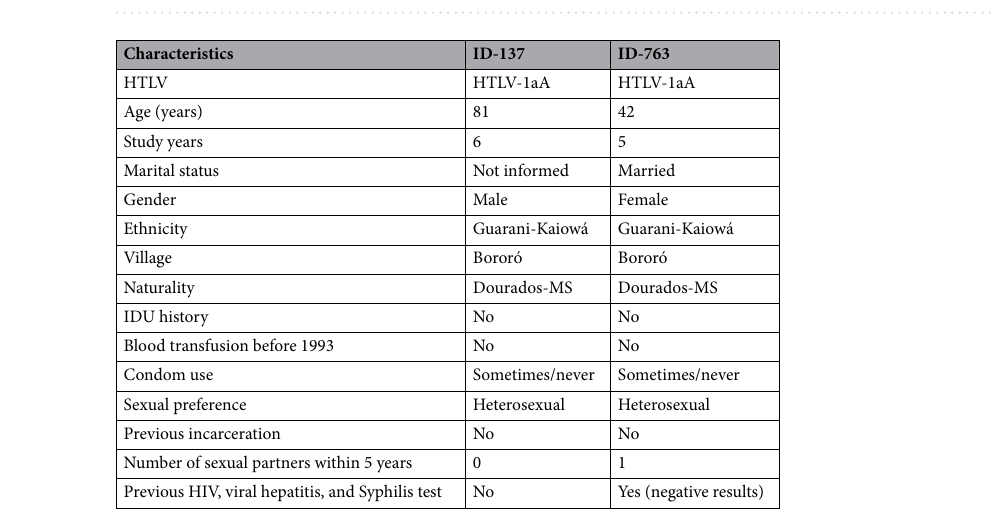
Figure 2. Phylogenetic tree of HTLV-1 subtypes from different groups. Phylogenetic tree constructed based on Maximum likelihood and Bayesian method with sequences of HTLV-1 5’LTR region from indigenous of this study (highlighted) and using 50 sequences from GenBank. Support for the branching was determined by 1000 bootstrap replicates and only values of 70% or superior was shown for Maximum likelihood and 0.9 or superior of posterior probability for Bayesian analyses. ID-137 (OM863789), ID-763 (OM863790) clustered with different population groups.